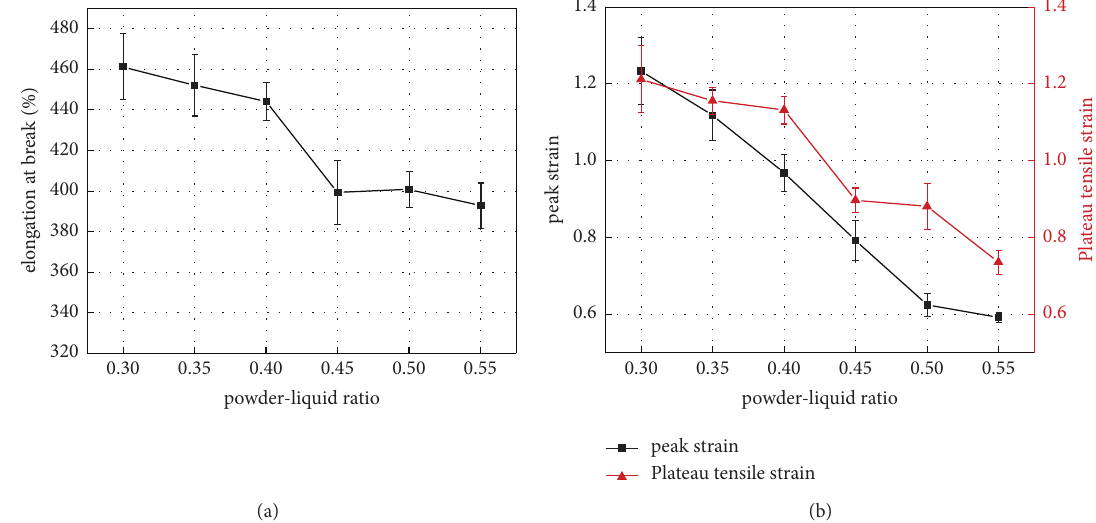
Figure 10: Changes of PCC tensile deformation indexes with powder-liquid ratio: (a) elongation at break; (b) peak